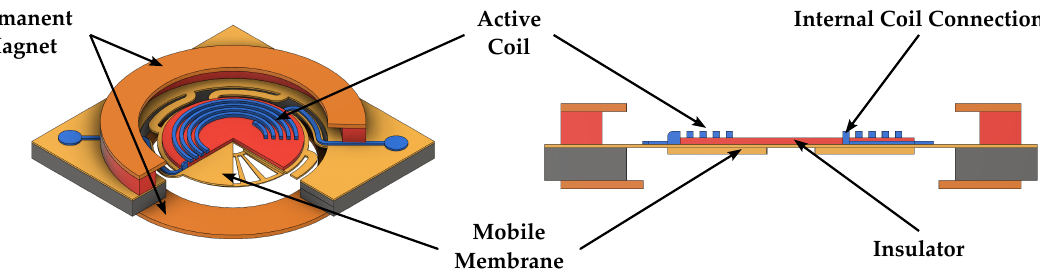
Figure 3. Schematic 3D view and cross section of an electromagnetic speaker employing the structure proposed in